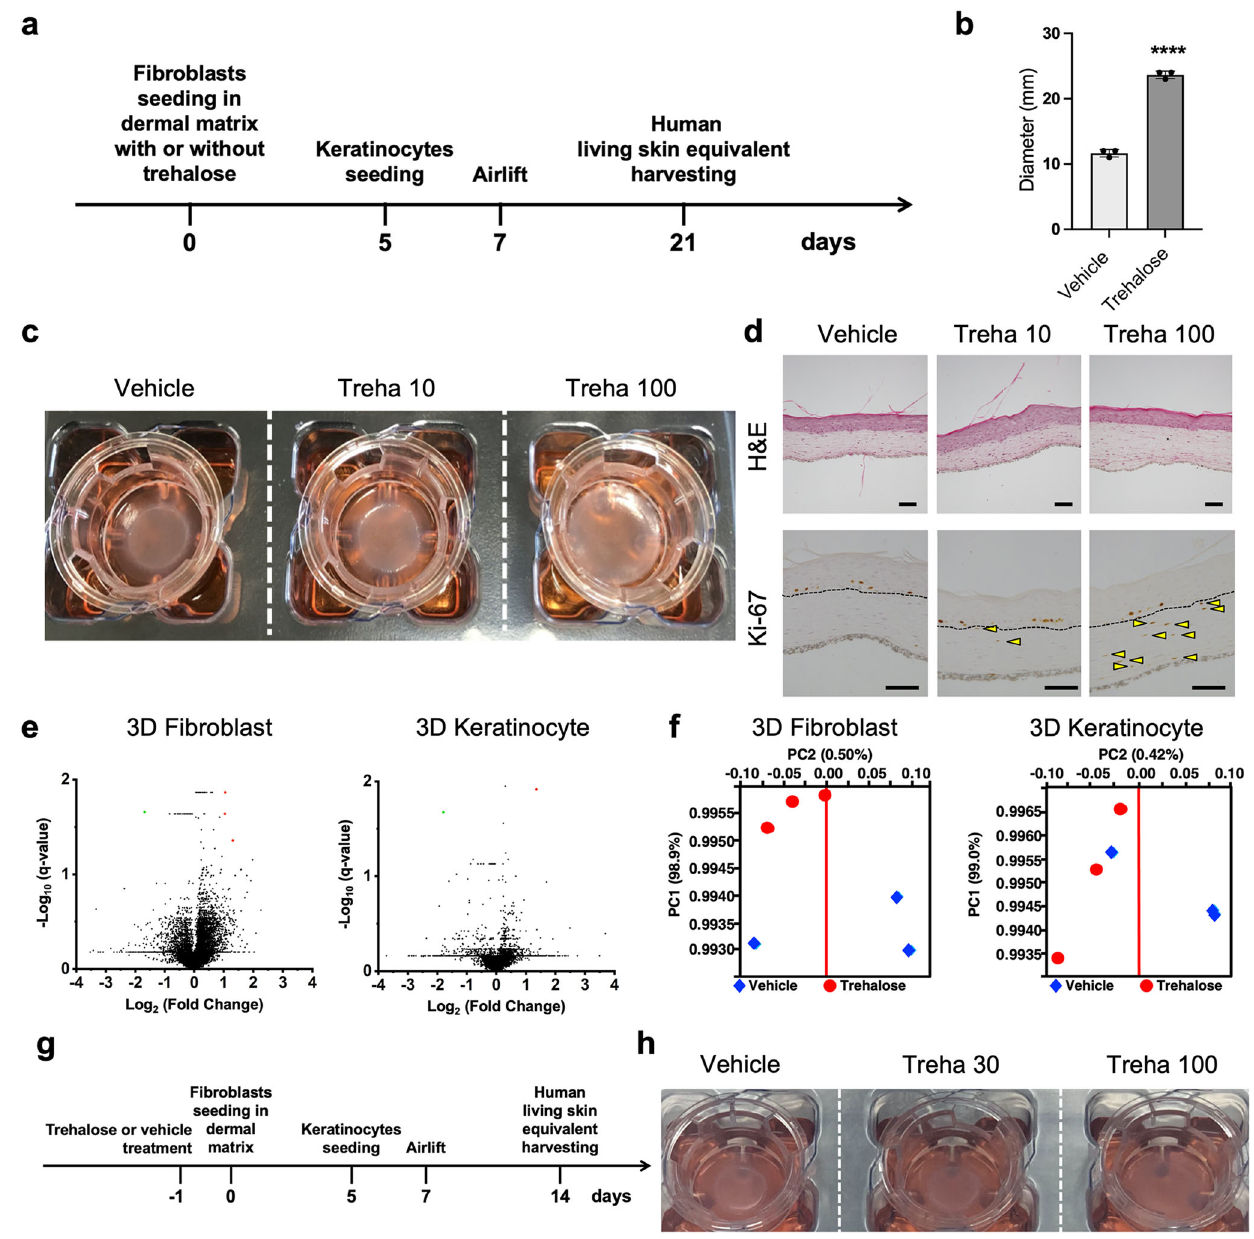
Fig. 1 Effect of trehalose in the preparation of living skin equivalents. a Schematic for the preparation of cultured skin equivalents. b Diameters of LSEs with or without trehalose (100 mg/ml) added in the collagen gel, prepared in the Transwell-COL with 24-mm insert in a six-well culture plate after 2-week airlifting at 37 °C. Data were expressed as means ± SD for three LSEs, which are representative of three independent experiments with similar results. **** P < 0.0001 versus vehicle control groups using the Student t -test. c Macroscopic pictures of LSEs with or without trehalose (10 and 100 mg/ml) added in the collagen gel after 2-week airlifting. d LSEs stained with hematoxylin and eosin (Scale bar = 50 μ m). Paraf fi n-embedded sections of LSEs were sectioned and subjected to immunohistochemistry with Ki67 antibody. Yellow arrowheads indicate the Ki67 positive fi broblasts in the dermis (Dotted line: dermal – epidermal junction, Scale bar = 100 μ m). e Volcano plots showing gene expression in the absence or the presence of trehalose. Red or green rounds indicate genes that increased by more than 2-fold or decreased by less than half, respectively, with less than 0.05 of q values. f A principal component analysis (PCA) with gene expressions in the absence or the presence of trehalose showed no clear separation between principal component PC1 and PC2. g Schematic for the preparation of cultured skin equivalents with fi broblasts treated with or without trehalose before seeding in the dermal matrix. h Representative picture of LSEs with the fi broblast treated with or without trehalose (30 and 100 mg/ml) before seeding in the collagen gel after 1-week airlifting at 37 °C. Data were representative of three independent dermal – epidermal junction of the three groups (Supplementary Fig. 3d). These data demonstrated that trehalose added to the collagen gel signi fi cantly accelerated the proliferation of epider- mal sheets, which are morphologically and histologically indis- tinguishable from vehicle-treated control LSEs.